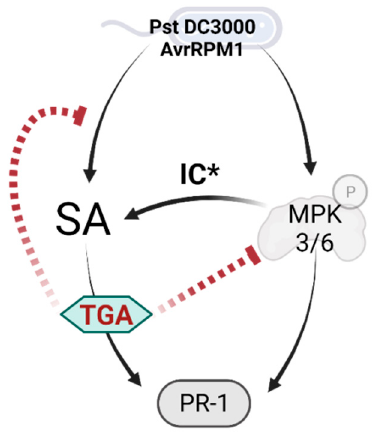
Figure 8. The ETI response activates PR-1 in an SA-dependent and an SA-independent fashion. The activation of PR-1 depends on TGA from clade II in the pathway dependent on SA. On the other hand, Mitogen–Activated Protein Kinases 3 and 6 (MPK3/6) activation triggers the SA-independent PR-1 induction [44]. Additionally, the activation of MPK3 induces the activation of genes that participate in SA accumulation (IC*) independently of SA [44]. According to our model, TGA factors from clade II (TGA) can repress the MPK3/6 branch. Thus, in the tga256 mutant plants, the repression of TGA over the MPK branch is absent, permitting increased SA accumulation (Figure 6), the genes (Figure 4), and the PR-1 expression (Figure 1) dependent on MPKs. It is also possible, and not mutually exclusive, that upon stimulation of SA accumulation by ETI, the TGA factors negatively feedback on SA accumulation by suppressing a step upstream of SA accumulation, independent of MPK3/6